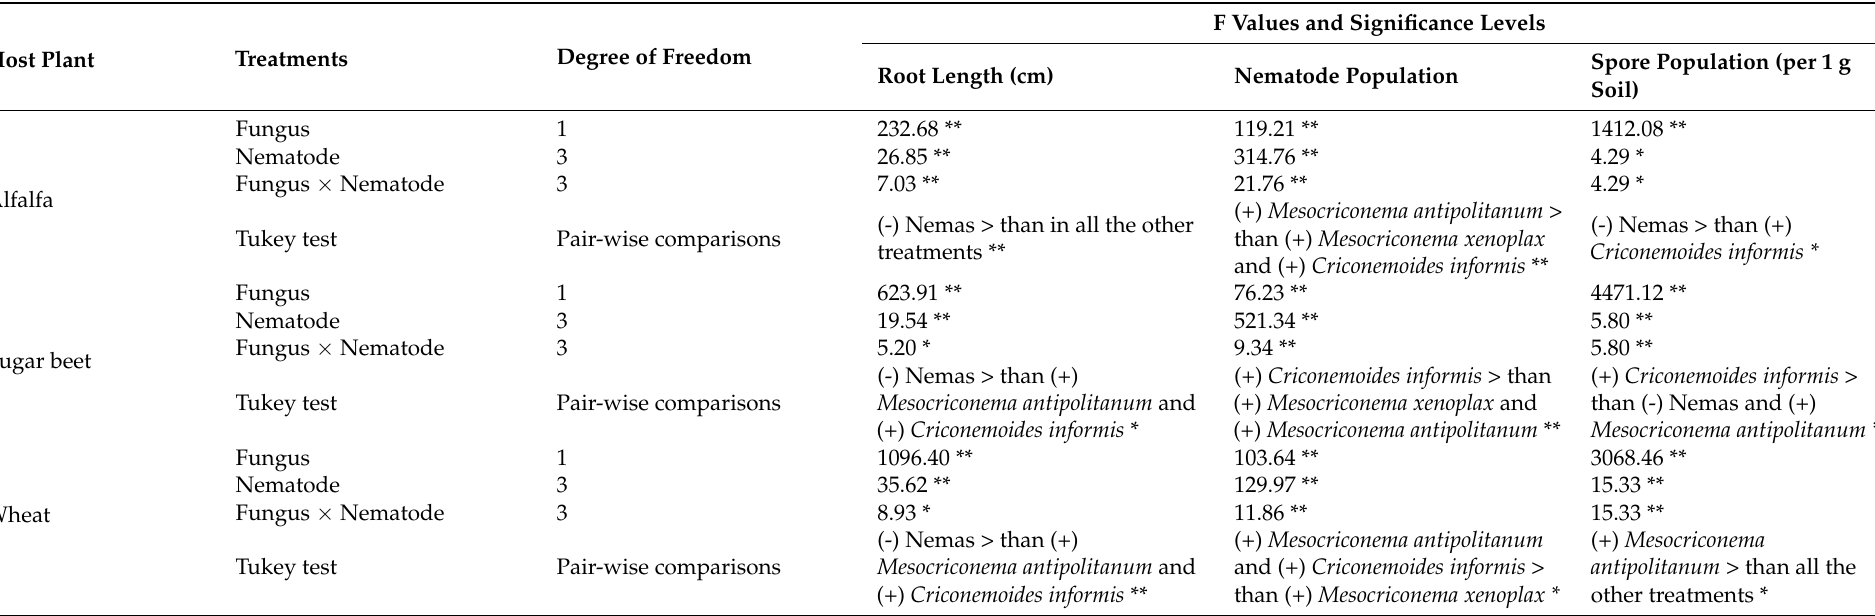
Table 2. Analysis of variance (ANOVA) on the effects of fungus and nematode treatments on the root length of alfalfa, sugar beet, and wheat; spore and nematode populations ((-) = without inoculation; (+): with inoculation; * p < 0.05; ** p <